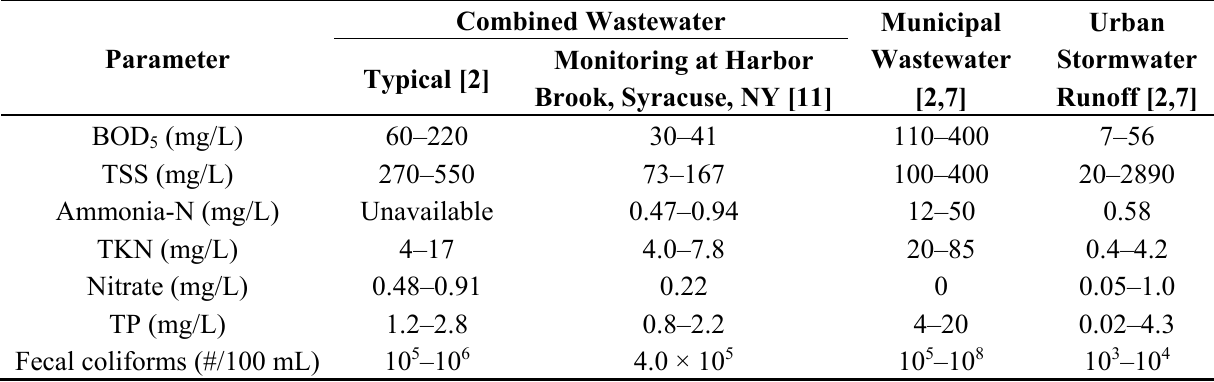
Table 1. Characteristics of combined sewer overflow (CSO) in comparison with municipal wastewater and stormwater in the